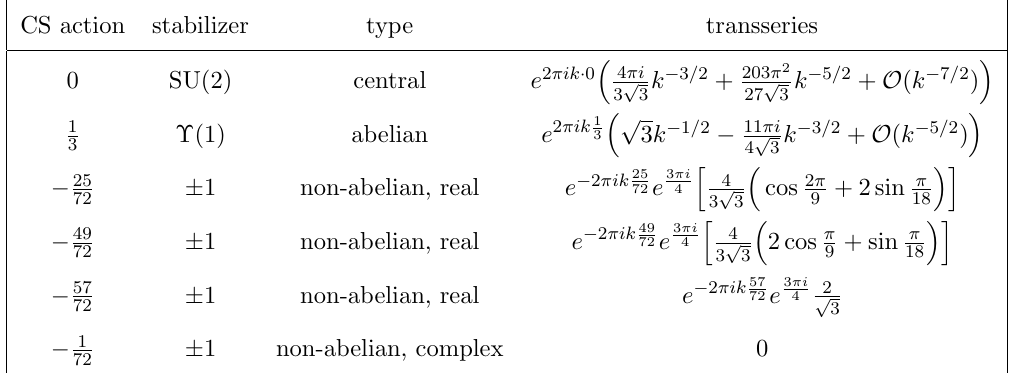
2; 1 ; 1 ; 1 2 3 9 (cid:0)